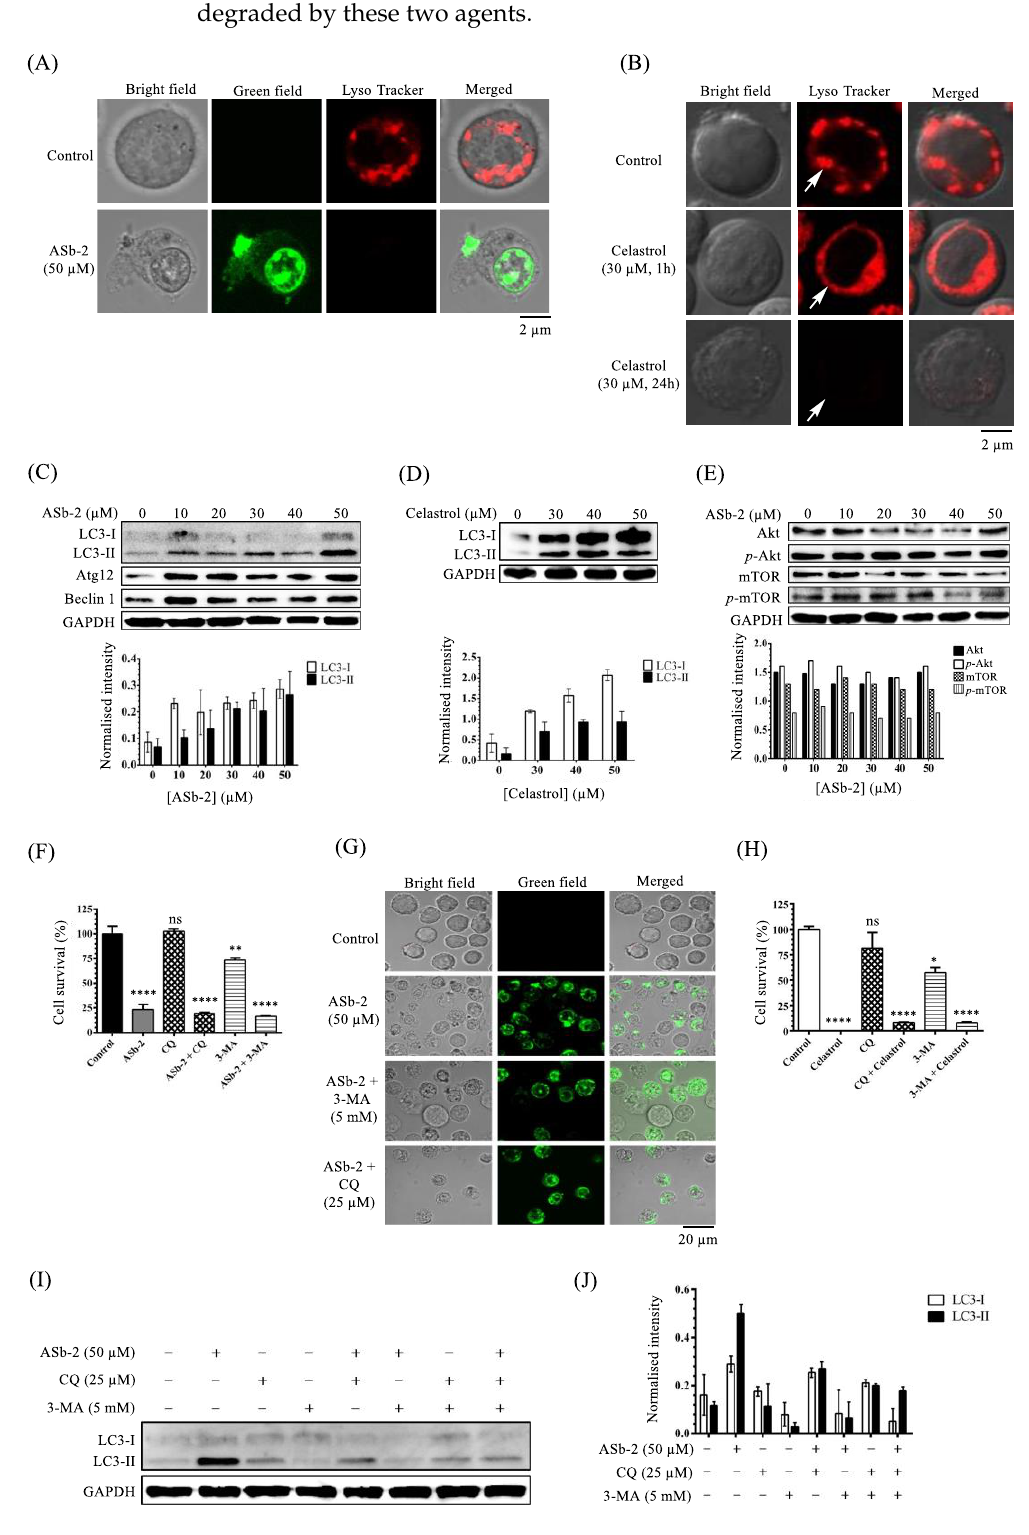
Figure 11. ( A , B ) Typical luminescence confocal microscopic images (Fluoview, FV-1000, Olympus) of Jurkat cells stained with LysoTracker red in the presence of ASb-2 (50 µM, 1 h) and celastrol (30 µM, 1 or 24 h) at 37 °C. ( C ) Autophagy markers such as LC3-I/II, Atg12, and beclin-1 were confirmed by Western blot analyses in Jurkat cells for 1 h at 37 °C. ( D ) LC3-I/II expression levels were confirmed by Western blot analyses in the presence or absence of celastrol in Jurkat cells